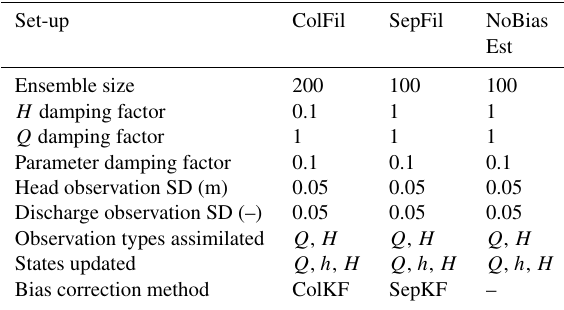
Table 2. Scenarios studied in the real data tests.